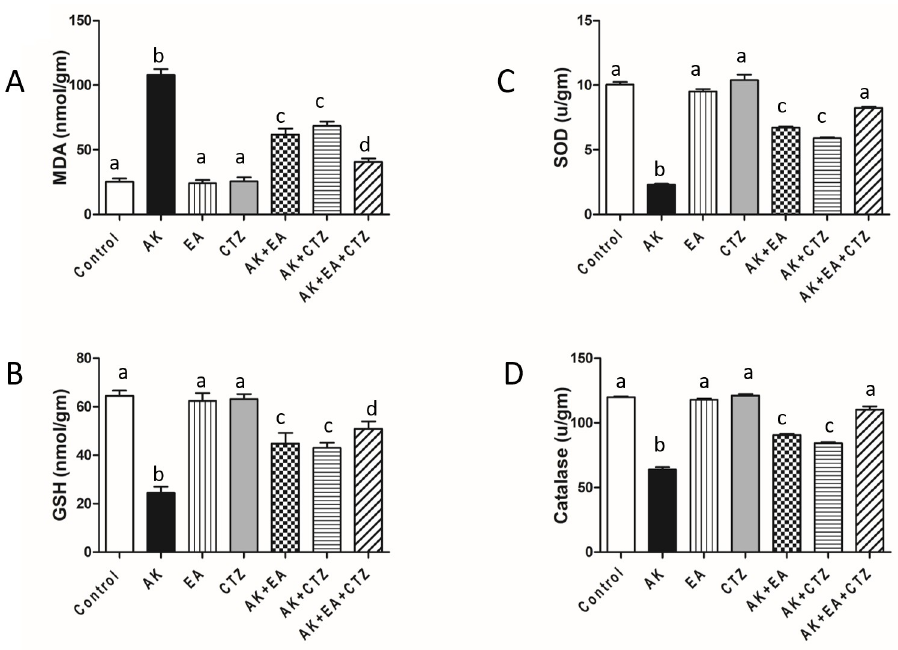
Fig 3. Effect of ellagic acid, cilostazol, and their combination on oxidative stress markers in renal tissue. Quantitative analysis of malondialdehyde (MDA) (A), reduced glutathione (GSH) (B), superoxide dismutase (SOD) (C), catalase (CAT) (D) in the renal tissue. Ellagic acid (EA) 10 mg/kg, cilostazol (CTZ) 10 mg/kg and their combination were administered one hour before intramuscular injection of amikacin 400 mg/kg for seven days. Groups were compared using one-way ANOVA and post-hoc Turkey ʼ s test. Values are indicated as mean ± SE (n = 7). Values without common small letters are significantly different ( p < 0.05).